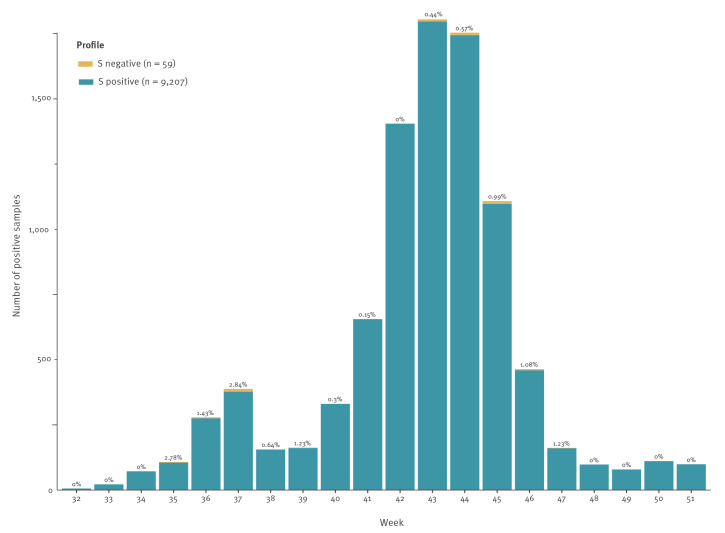
Prevalence of the S negative profile (negative for S target and positive for N and ORF1ab targets) with TaqPath COVID-19 RT-PCR kit, Lyon, France, 3 August (week 32)–20 December (week 51) 2020 (n = 9,266 samples tested)